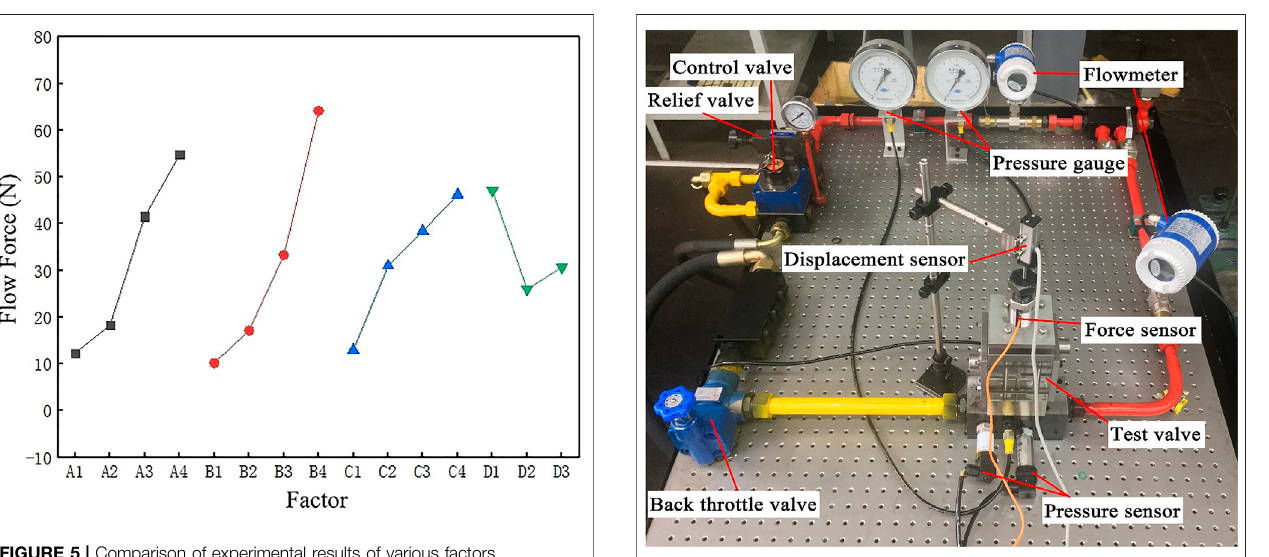
FIGURE 6 | Experimental